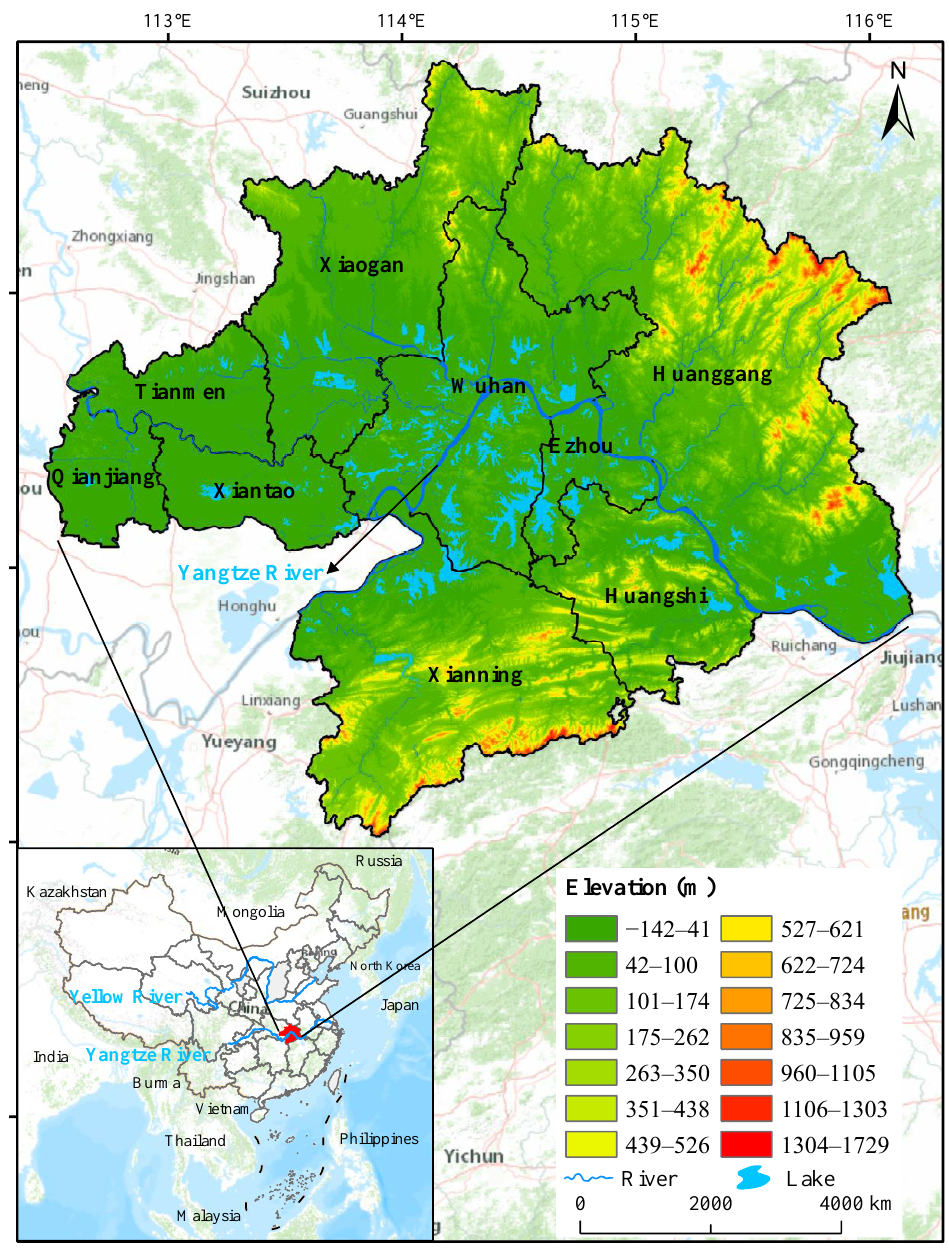
Figure 1. Location of Wuhan Urban Agglomeration Area (WUAA). Pretreatment included cloud removal and a water mask. The quality assessment band generated by the C Function of Mask (CFMask) algorithm is used for cloud removal of Landsat images, which increases the integrity of the research by indicating which pixel might be affected by instruments or clouds (http://www.usgs.gov/land-resources/nli/ Landsat (accessed on 1 April 2022)). The specific process is as follows: select a pixel covered by cloud shadow, with cloud and medium cloud confidence, and set its pixel value to